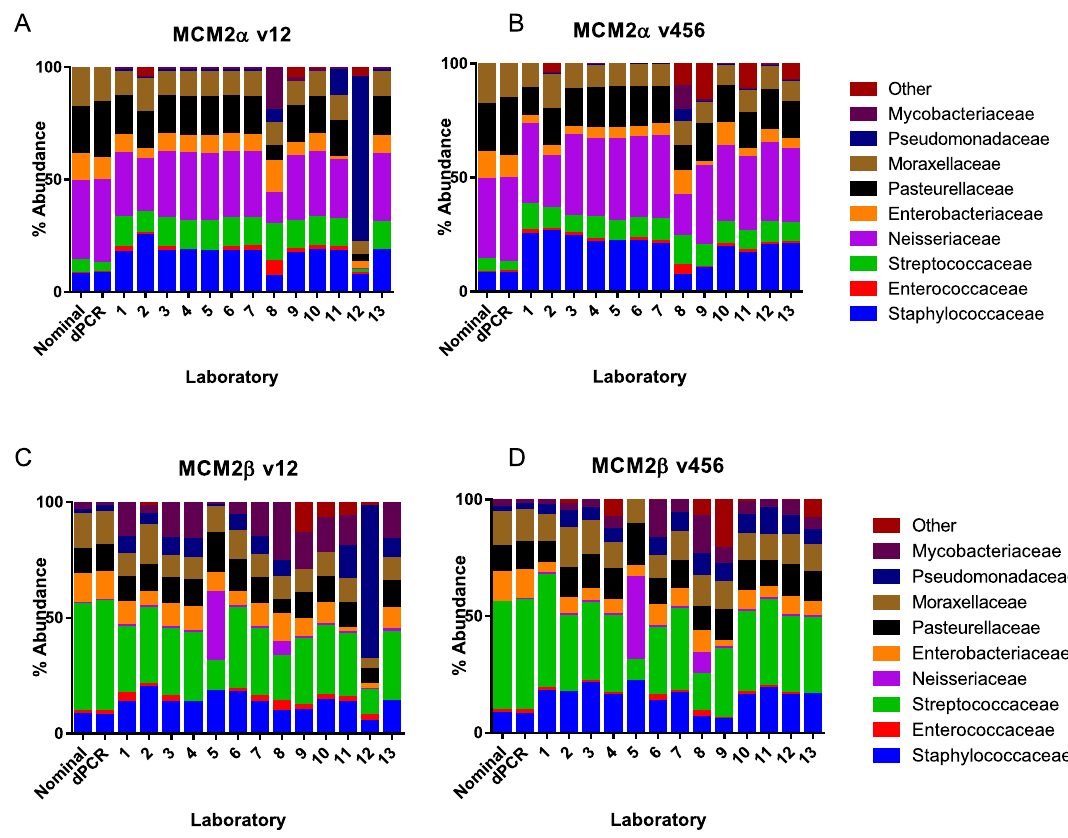
Figure 1. ( A – D ) The % family abundance reported by each laboratory including the nominal and dPCR reported composition for the two materials; MCM2α, variable regions V1–2 ( A ) and V4–6 ( B ) and MCM2β, variable regions, V1–2 ( C ) and V4–6 ( D